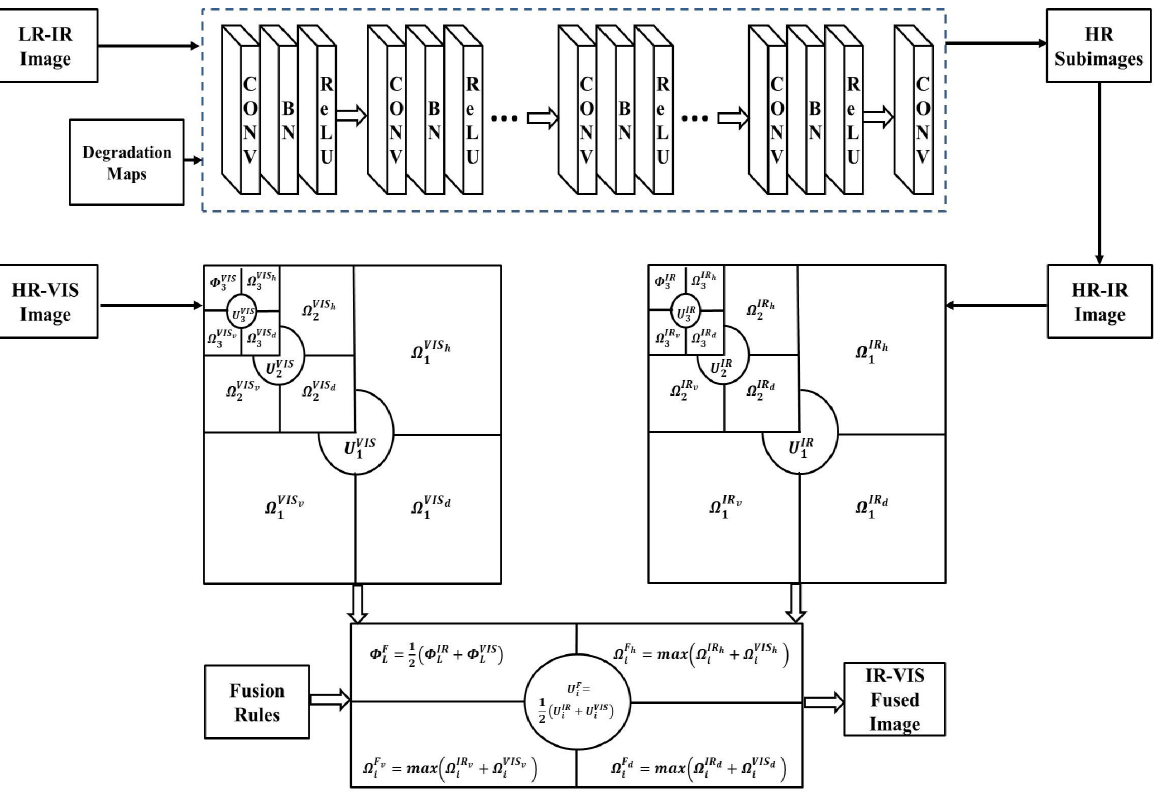
Figure 2. Proposed IR-VIS image fusion